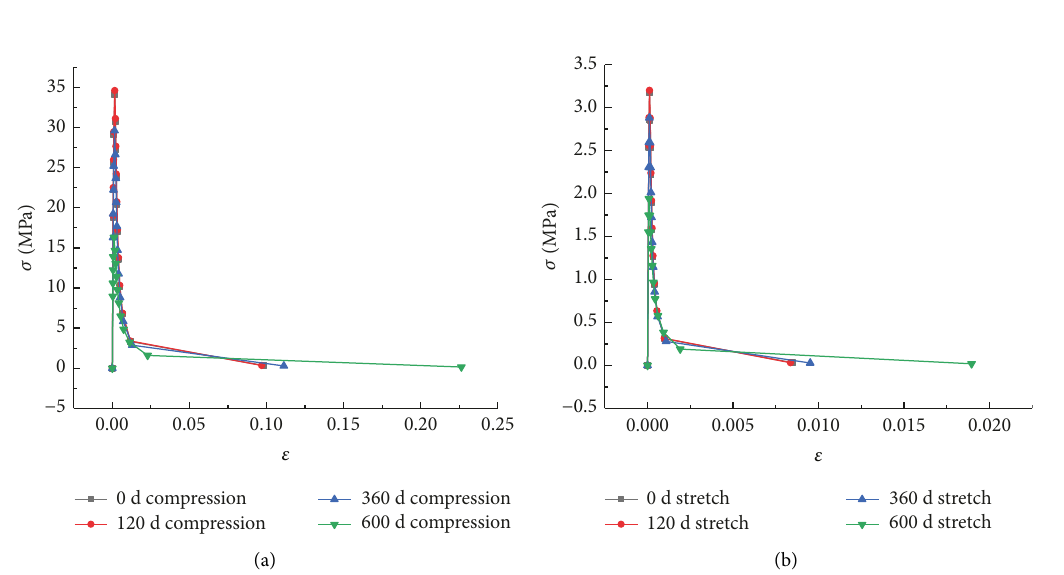
Figure 6: Comparison of stress-strain curves of concrete under different corrosion days. (a) Compressive stress-strain curve of the concrete test block. (b) Tensile stress-strain curve of the concrete test block.